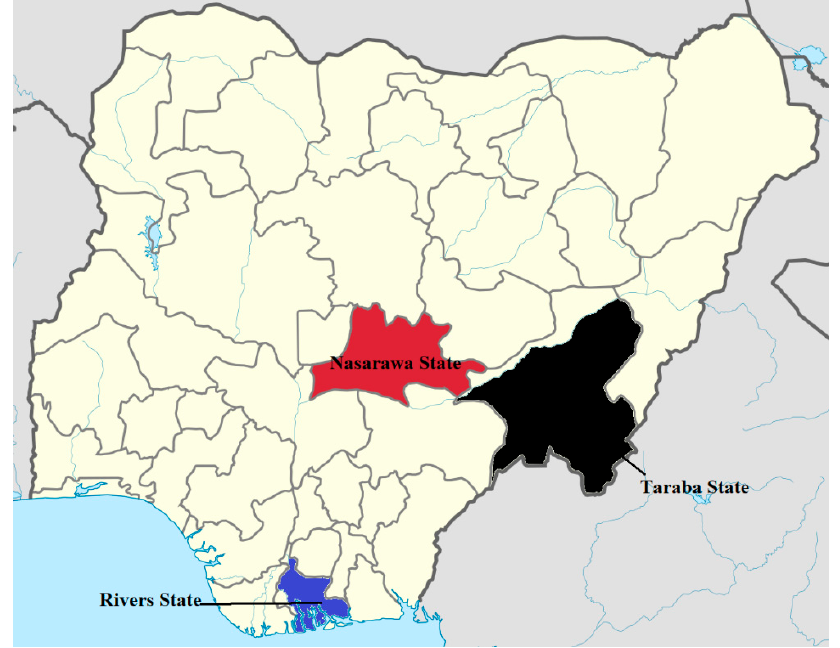
Figure 1. Map of Nigeria showing active mining sites for various minerals [18]. The location and local Government area of the mine sites is shown in Table S1 (Supplementary Materials).